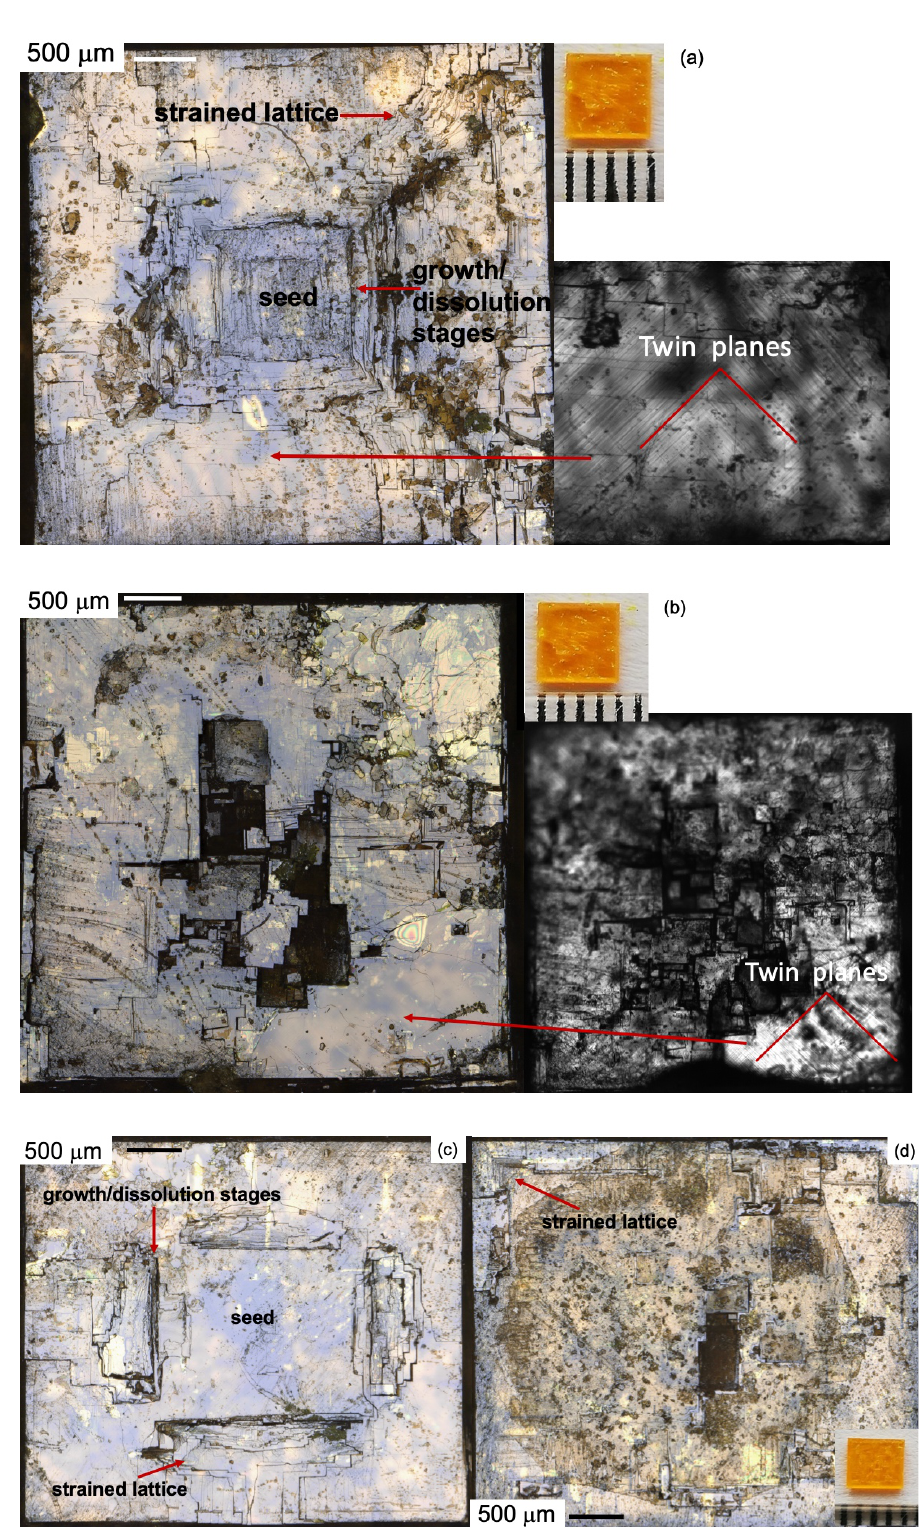
Figure 2. Sample (BA) 2 CsAgBiBr 7 _Exp1 (4 × 4 × 0.75 mm 3 ) has a top crystal surface ( a ) and bottom surface ( b ) characterised by irregular growth and dissolution features (image on the left made in reflected light), strained lattice and defects such as twin planes at 90 ◦ (image on the right made in transmitted light). Sample (BA) 2 CsAgBiBr 7 _Exp4 (3.5 × 3.5 × 0.75 mm 3 ) has more regularly spaced segregation lines in the top crystal face ( c ), while its bottom crystal face has a higher density of defects, such as inclusions and precipitates ( d ). Both crystal faces exhibit bent lattice in the overgrowth